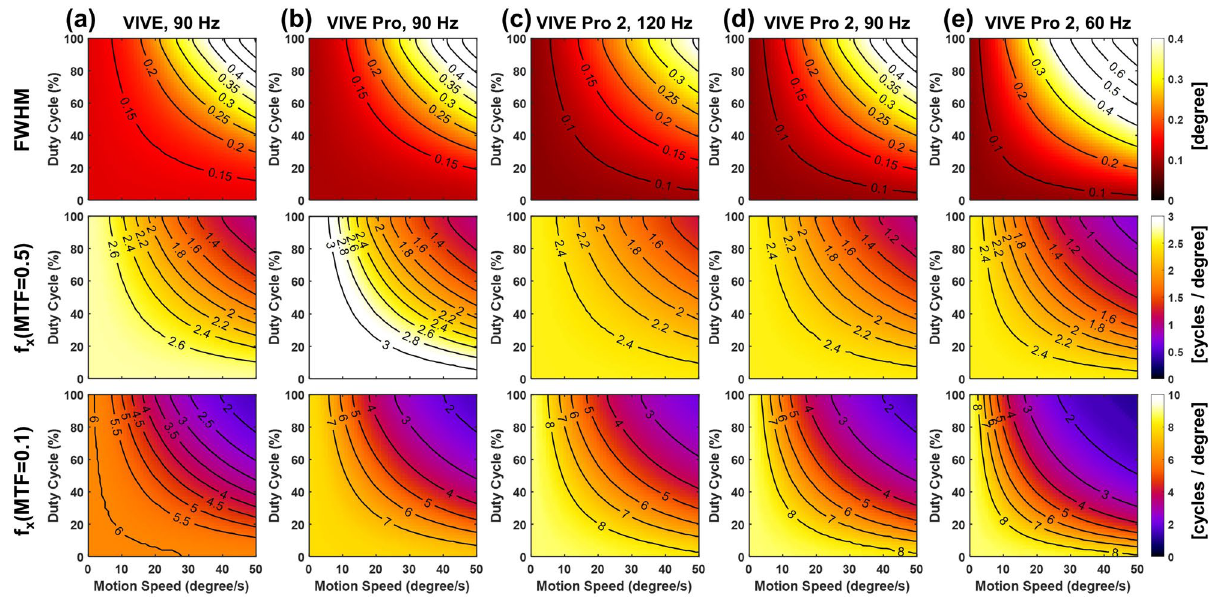
Figure 9. FWHM (first row), spatial frequencies at MTF = 0.5 (second row) and 0.1 (third row) with varied display duty cycle and motion speed for ( a ) the VIVE at 90 Hz, ( b ) the VIVE Pro at 90 Hz, ( c ) the VIVE Pro 2 at 120 Hz, ( d ) the VIVE Pro 2 at 90 Hz, and ( e ) the VIVE Pro 2 at 60 greater than 0.4° using 100% duty cycle (as in conventional flat-panel displays) to less than 0.15° using 17% duty cycle as in the VIVE and VIVE Pro at 40°/s target motion speed. Regarding the dynamic resolution, the VIVE Pro achieves the best low to mid-frequency spatiotemporal resolution at MTF = 0.5. For instance, f x ( MTF = 0.5 ) is